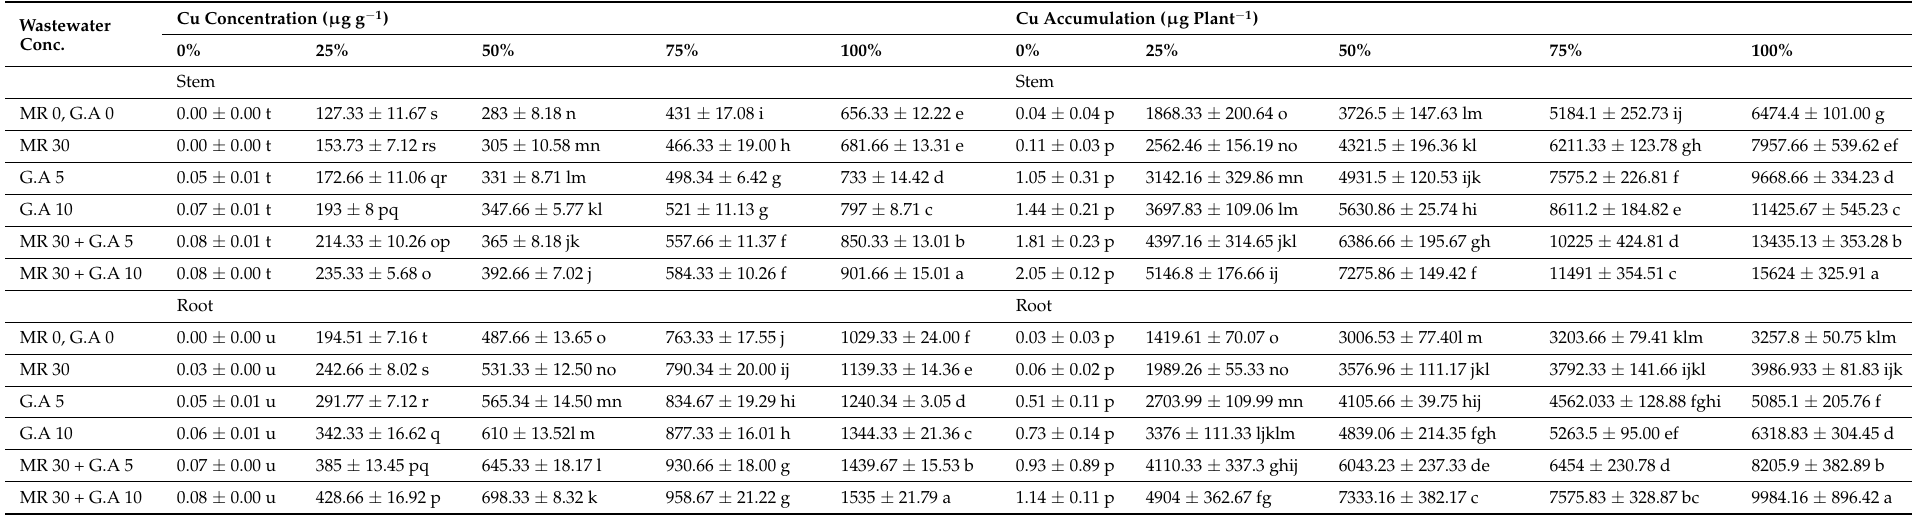
Values are demonstrated as means of three replicates along with standard deviation. Different small letters indicate that values are significantly different at p < 0.05. Table 3. Effect of surgical and textile effluent alone and/or in combination with GA on heavy metals uptake ( µ g g − 1 ) and accumulation ( µ g plant − 1 ) in microwave-treated and -untreated